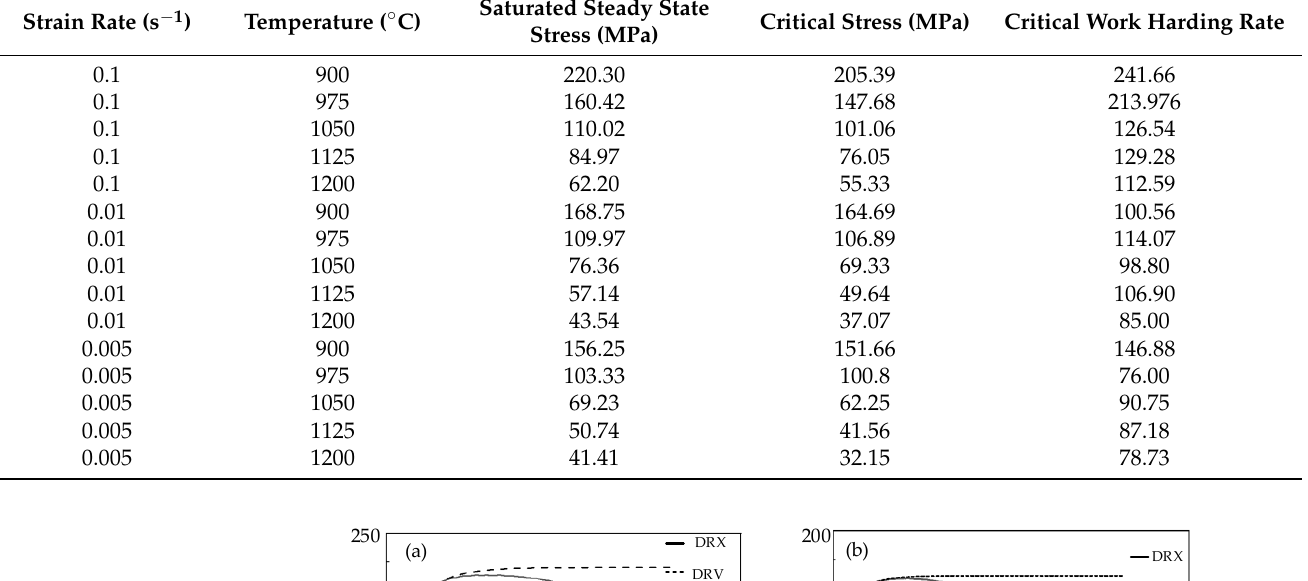
Table 4. Saturated steady state stress σ sat , critical stress σ c and critical work − hardening rate θ c of Cr8 alloy steel.